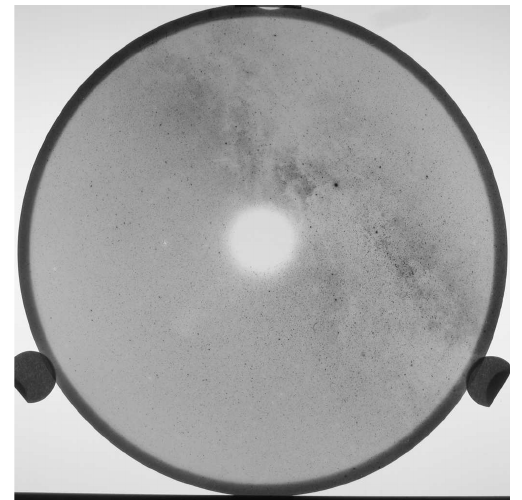
Figure 5: Example of digitized film from SAO Baker Super Schmidt